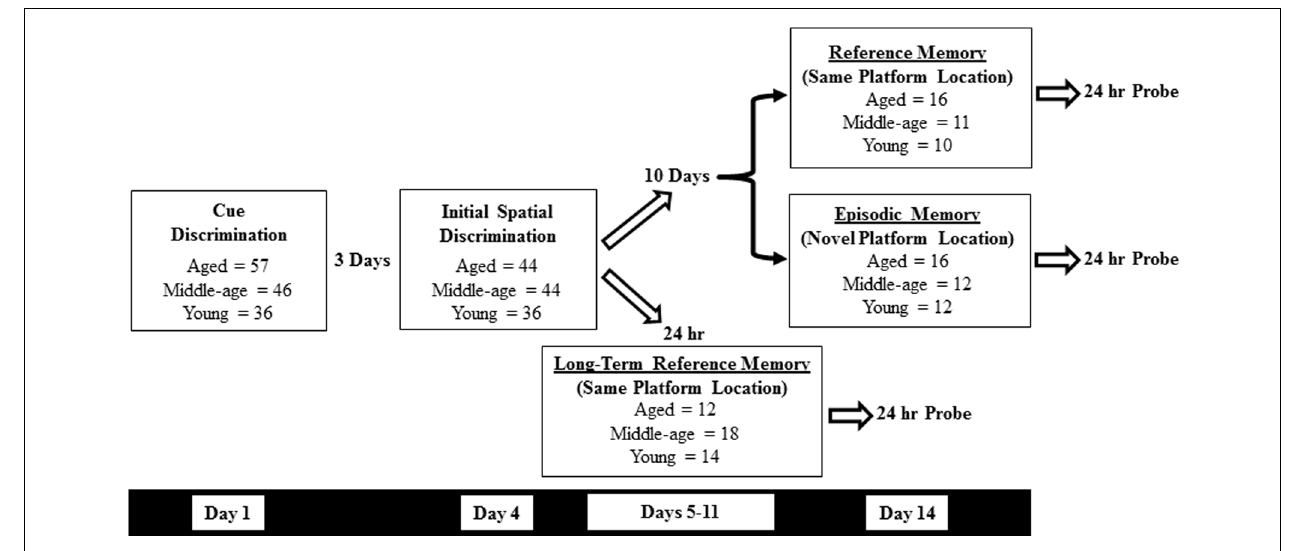
FIGURE 1 |A schematic overview of the experimental design and training cohorts used in the current study. Following cue (day 1) and the initial spatial discrimination training (day 4), animals were further divided into three groups for additional water maze testing: one day